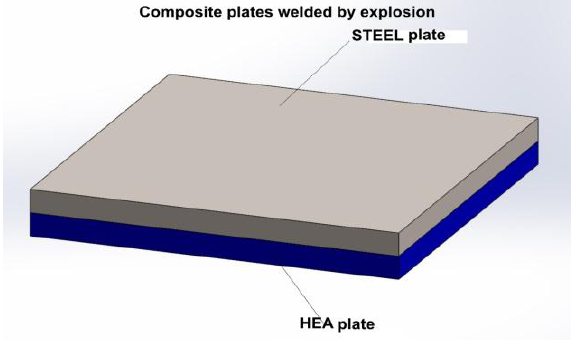
Figure 1. Composite plate welded by explosion.